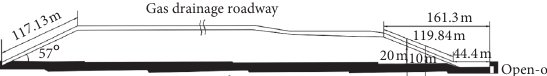
Figure 9: Profile of GDR.